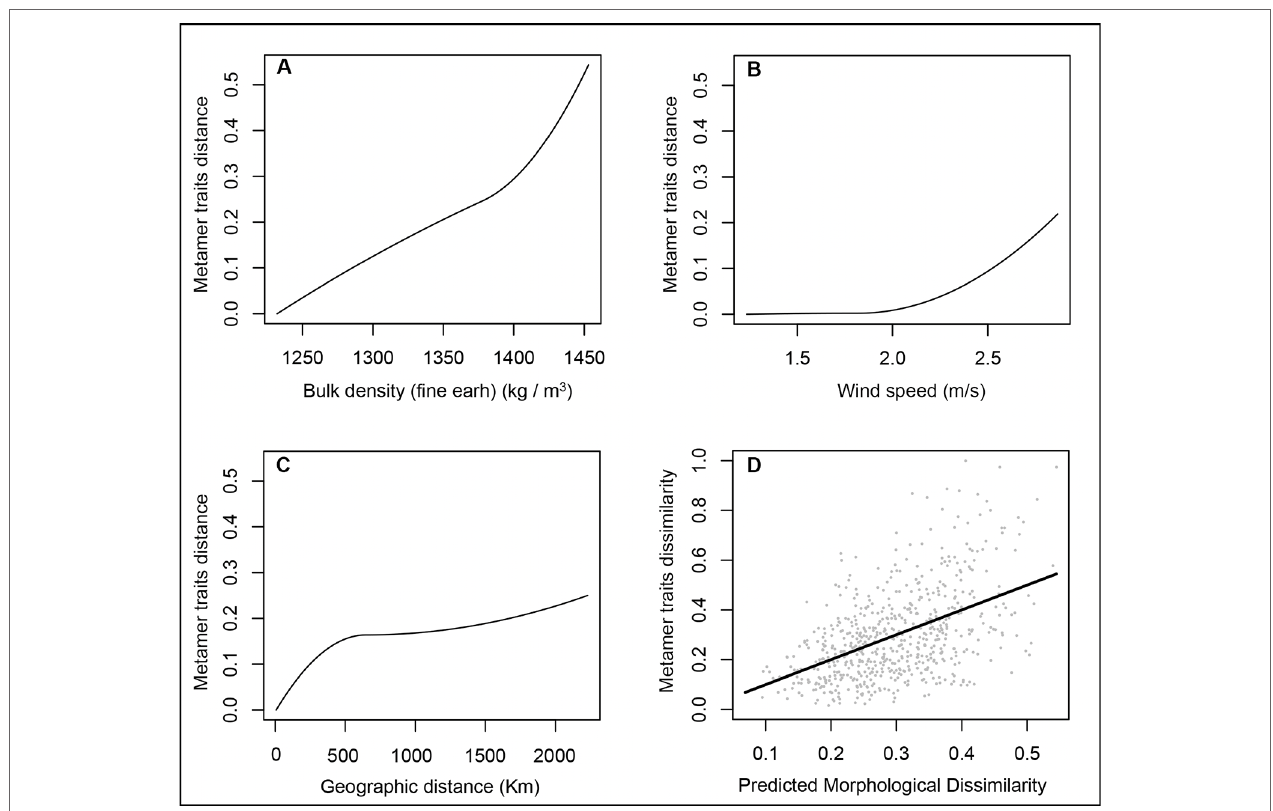
FiGUrE 4 | GDM-fitted I-splines for the bulk density (A) , wind speed (B) and geographic distance (c) associated with metamer trait dissimilarity in Qualea grandiflora . The maximum height of each curve indicates the total amount of metamer differentiation associated with that variable holding all other variables constant and the curve shape shows how the rate of metamer trait differentiation varies along the gradient. ( Panel D) illustrates observed versus predicted metamer trait dissimilarity.